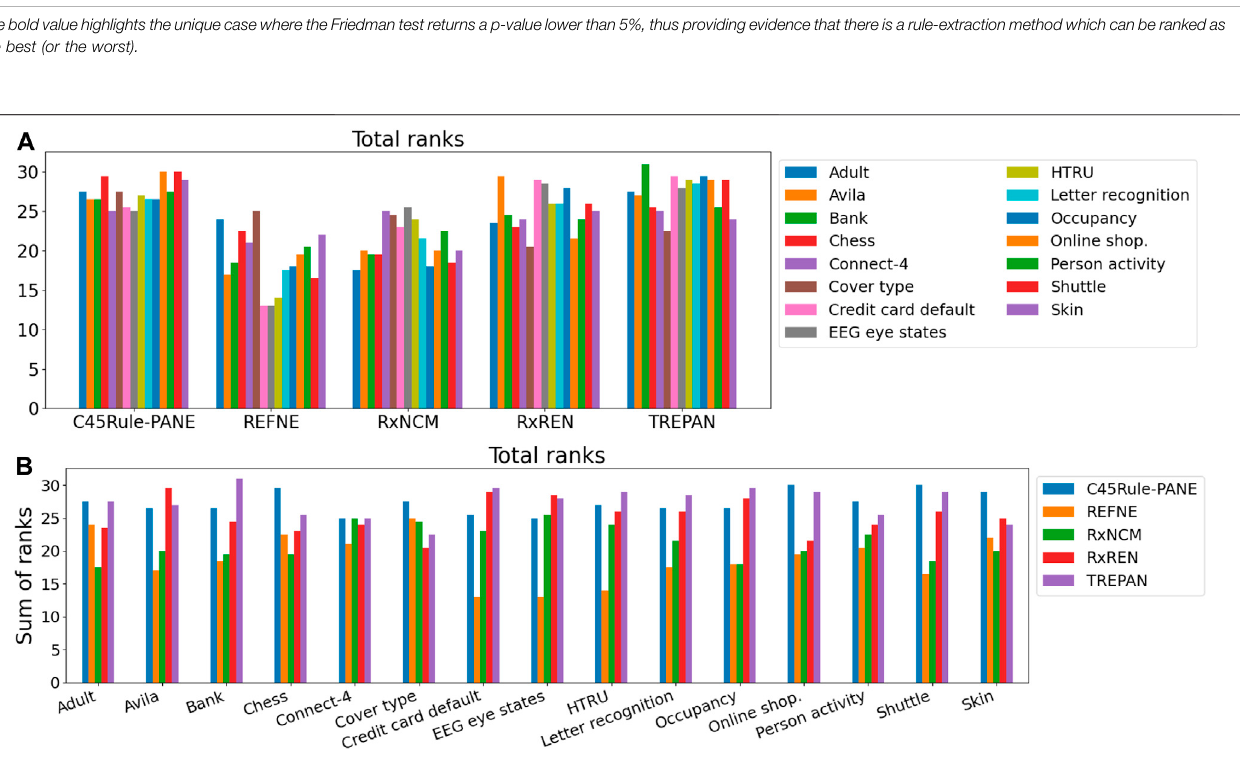
FIGURE 11 | Total ranks of the fi ve rule-extraction methods, grouped by methods (A) and datasets (B) .